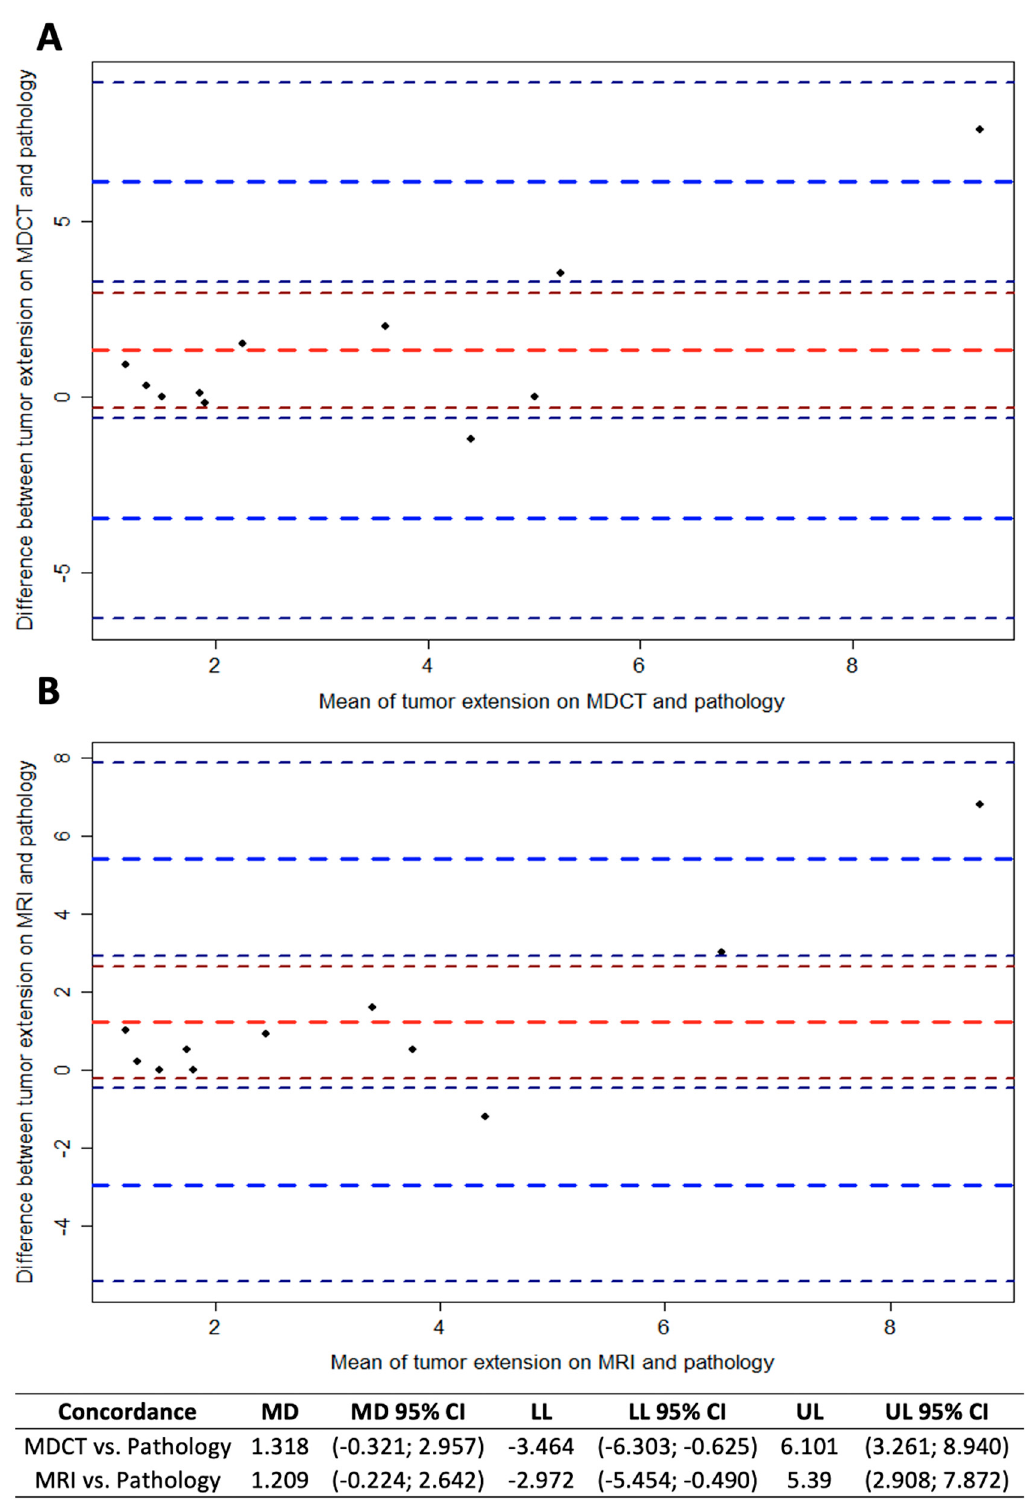
Figure 4. Bland–Altman plots for comparison of the differences between the tumor sizes on MDCT (A) or MRI (B) and pathology in breast cancer patients ( n = 11). Red line represents mean differences with 95% CI (dark red lines), blue lines represent the limits of agreement (upper and lower limits) with 95% CI (dark blue lines), and each dot represent an included case.